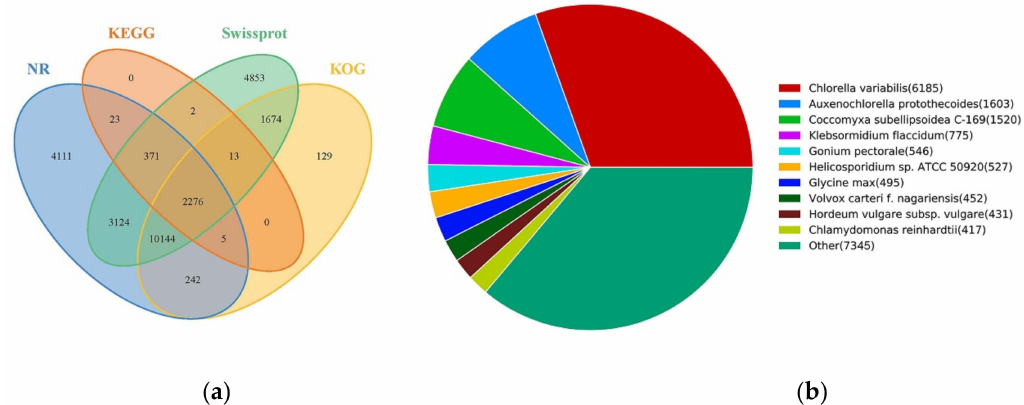
Figure 3. Function annotations of transcripts based on BLAST against diverse databases. ( a ) Venn diagram of transcripts annotated; ( b ) classification of species with gene homology based on NR annotation result.